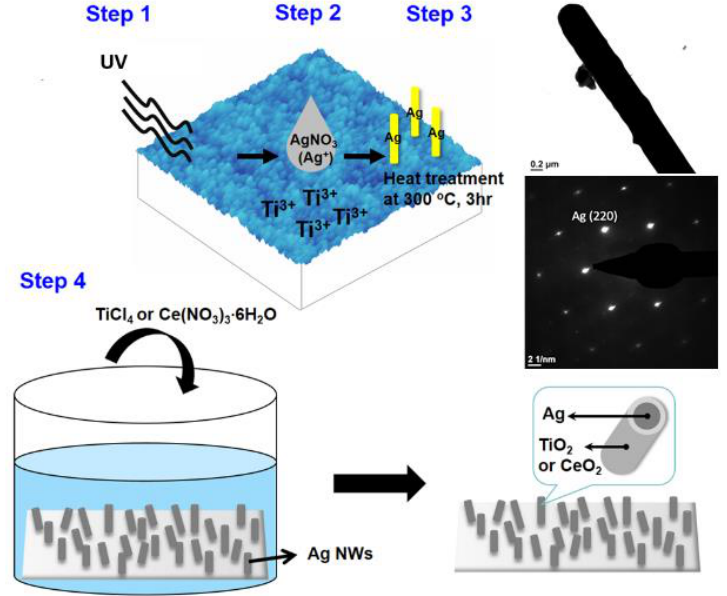
Figure 1. Synthesis process schematic illustration of the steps for obtaining Ag nanowires with multi-oxide-shells, including step 1. UV irradiation on TiO 2 substrate, step 2. Dropping AgNO 3 solution on TiO 2 substrate, step 3. Heat treatment for forming Ag nanowires, and step 4. Coating of outer oxide shells, as well as the TEM analytical results of the synthesized Ag nanowires (TEM